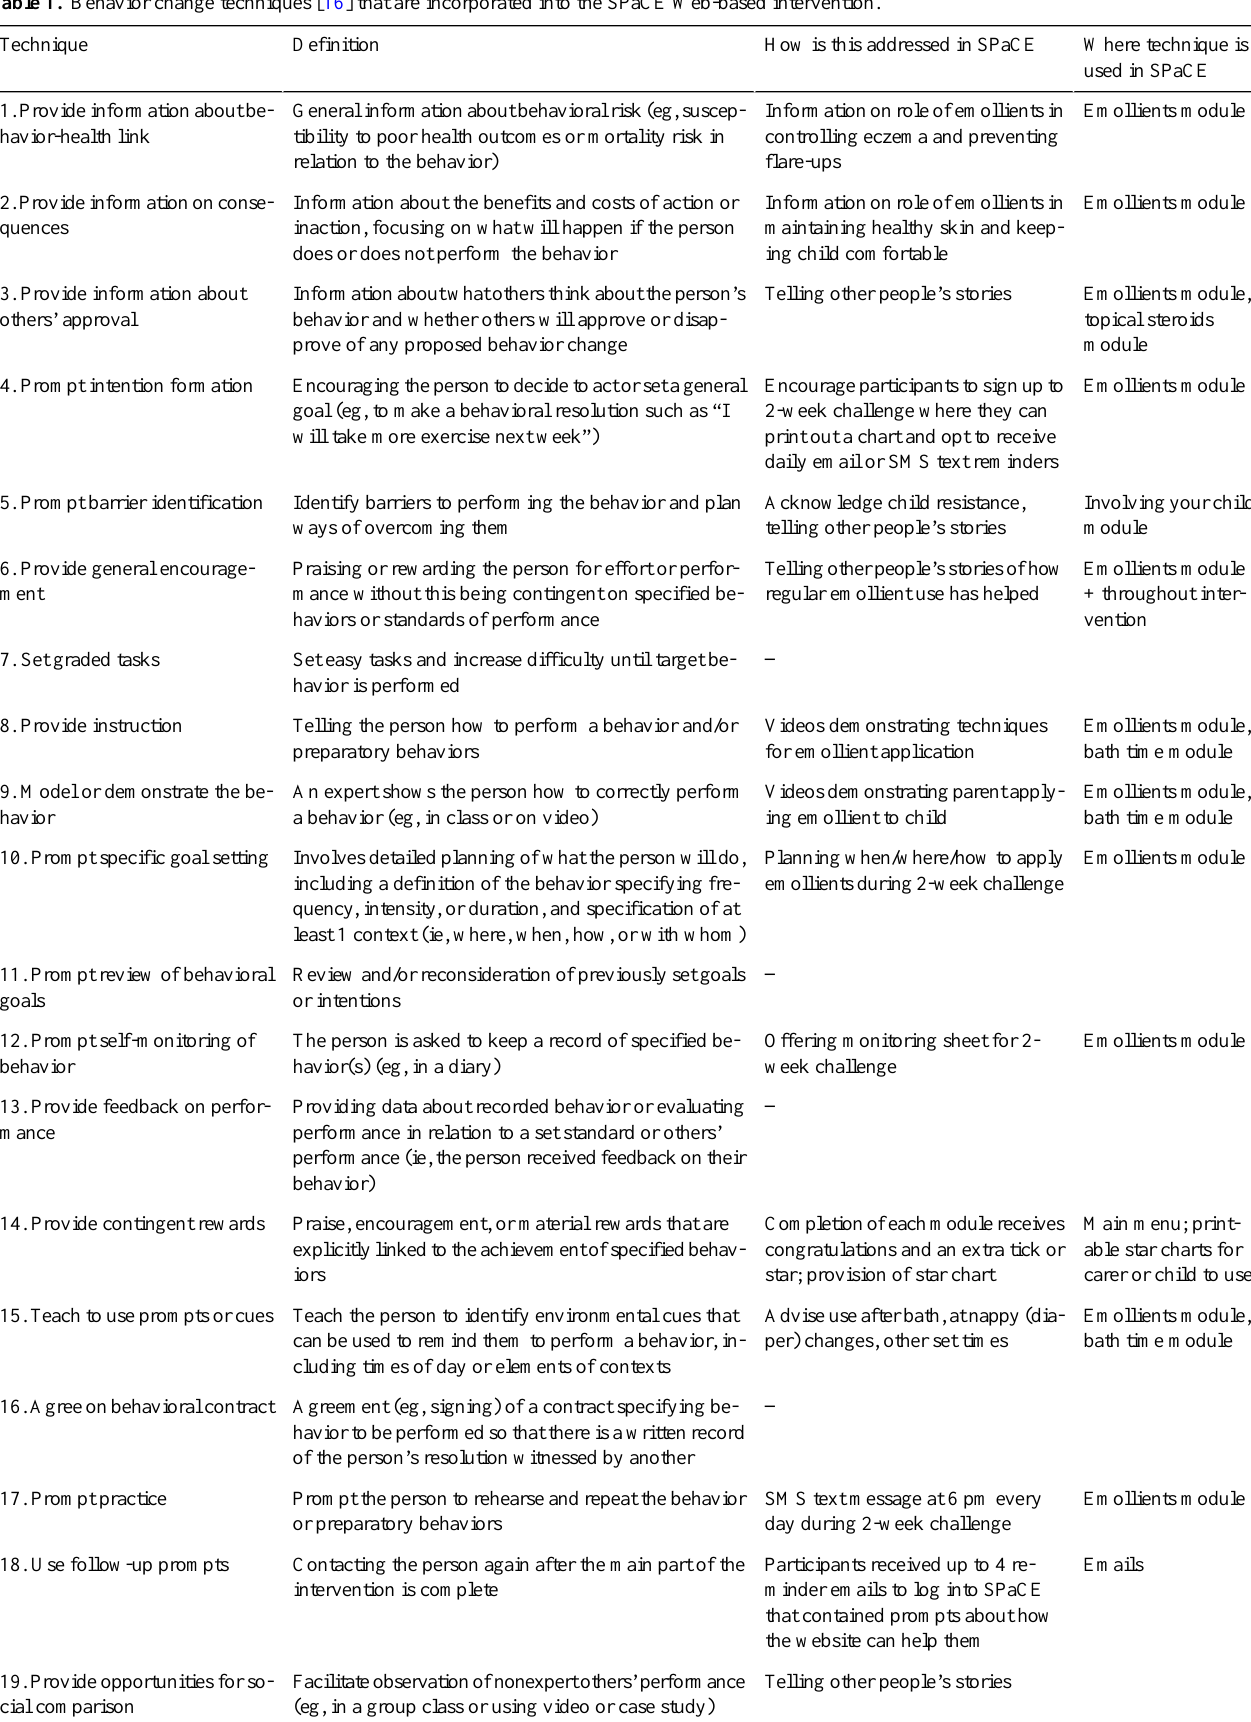
Table 1. Behavior change techniques [16] that are incorporated into the SPaCE Web-based intervention.